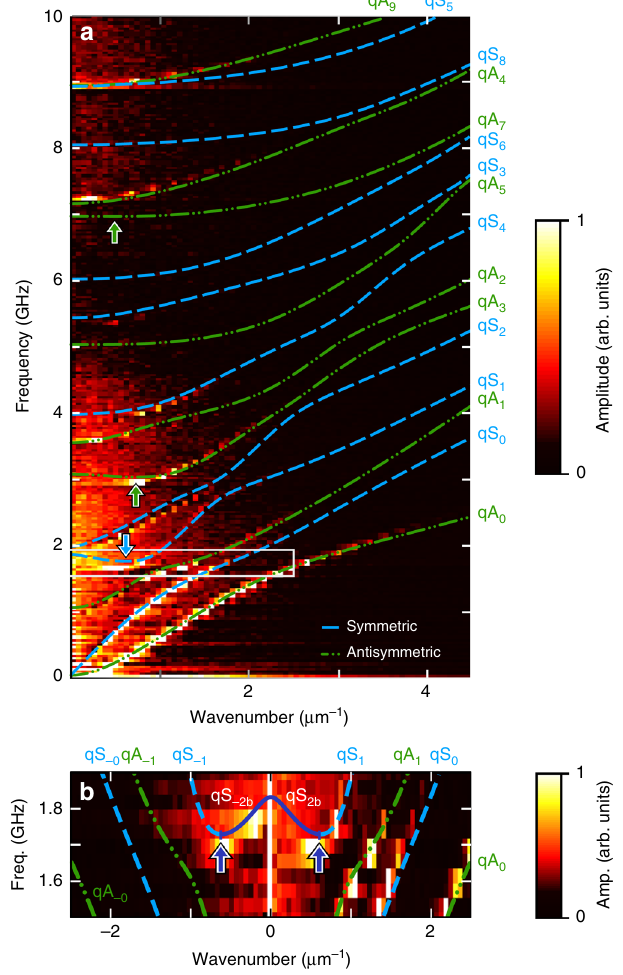
Fig. 3 Dispersion curves of the bilayer. a , b Experimental (image) and theoretical (blue dashed and green dotted-dashed lines) dispersion curves for a 0 ≤ f ≤ 10 GHz and 0 ≤ k ≤ 4.5 μ m − 1 b at frequencies near the fi rst ZGV mode for 1.5 ≤ f ≤ 1.9 GHz and − 2.5 ≤ k ≤ 2.5 μ m − 1 . The solid navy blue section of the dispersion curves corresponds to the portions where the phase and group velocities are anti-parallel. a The box corresponds to the enlarged region in b for k > 0. a , b Arrows indicate ZGV points.